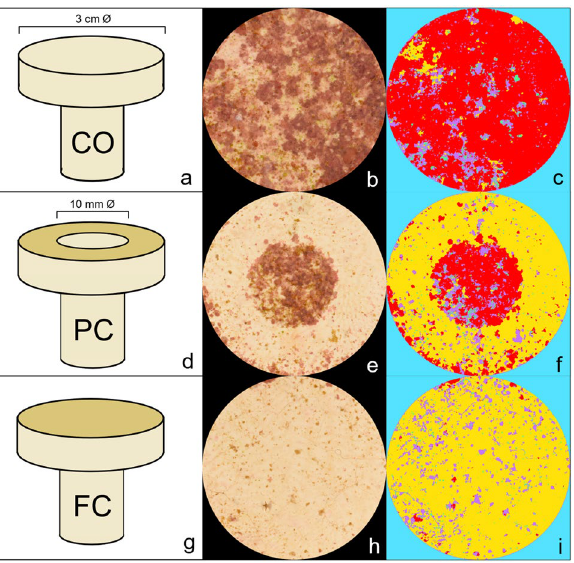
Figure 1. Uncoated Control (CO; a) , partially-coated (PC; d ), and fully-coated (FC; g ) plugs, cropped images of CO ( b ), PC ( e ), and FC ( h ) DCOIT plugs (after 37 days in the aquaria), and the segmentation of fouling classes on the same CO ( c ), PC ( f ), and FC ( i ) DCOIT plugs, using machine learning-based image classification with the Trainable Weka Segmentation (TWS) in ImageJ. Each fouling class was segmented using a specific color ( c , f , i ): red (CCA), violet (brown algae), green (green algae), yellow (bare substrate), blue